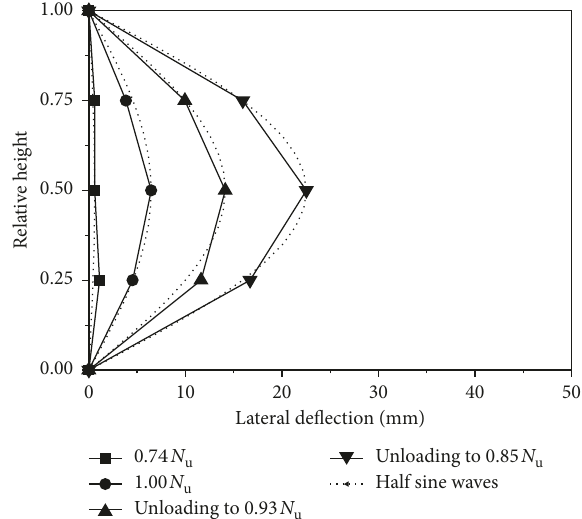
Figure 3: Typical load-lateral deflection curves (specimen t3-